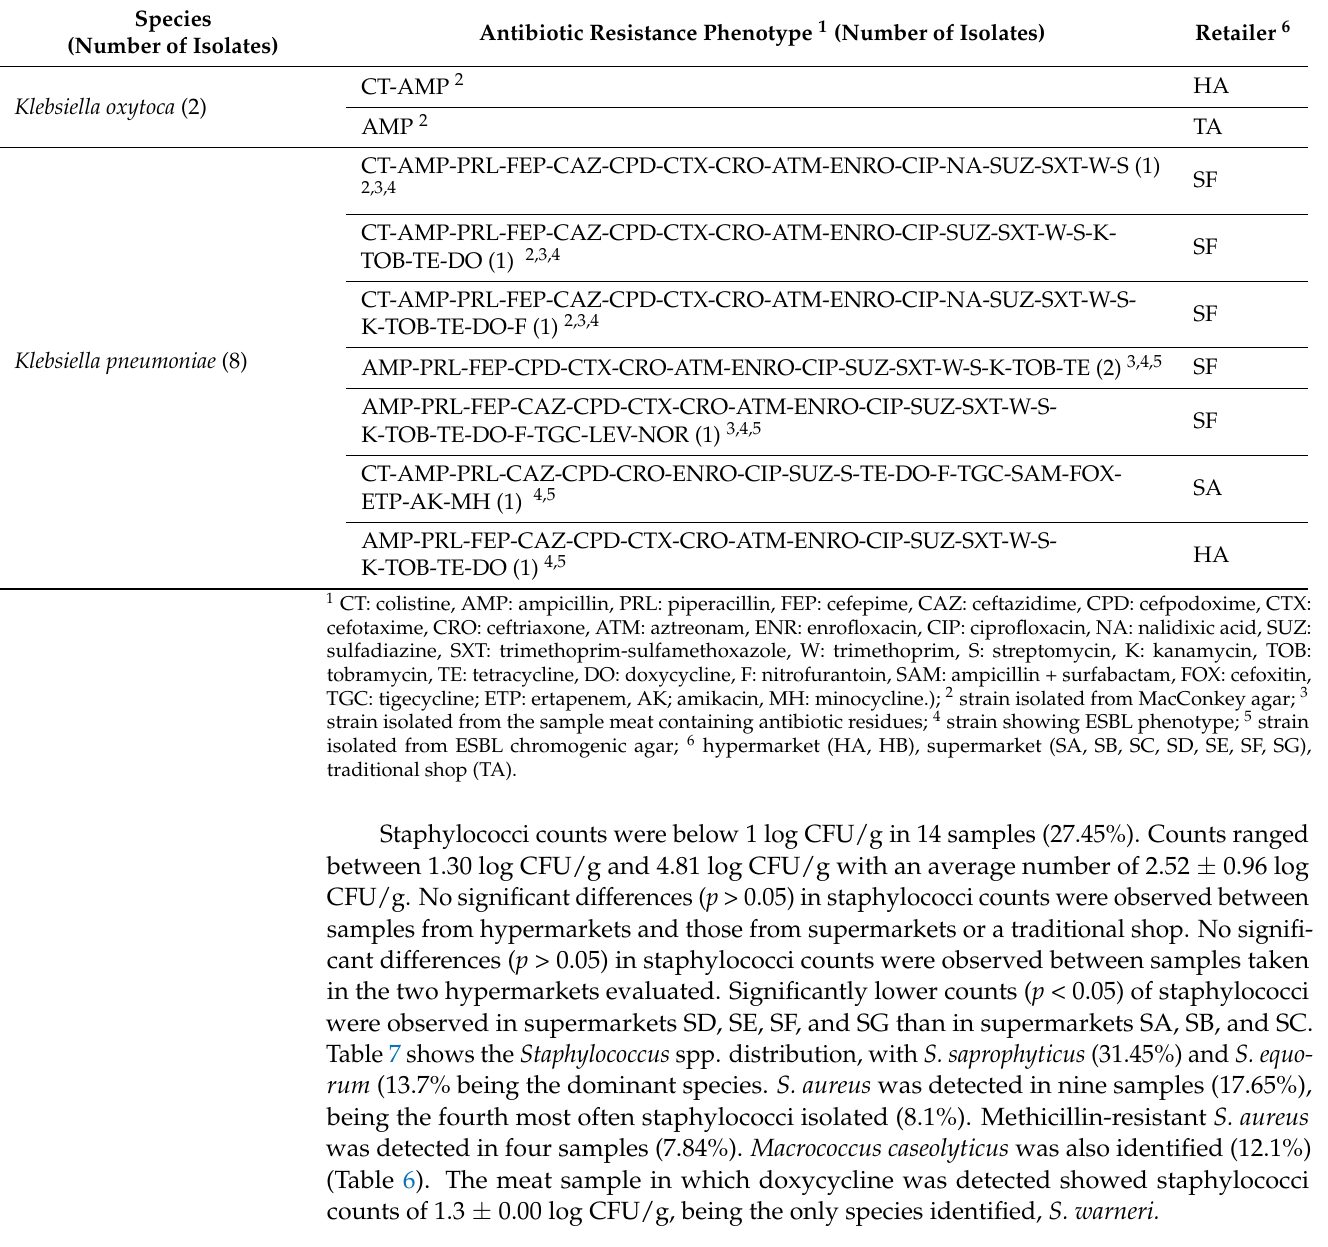
Table 6. Antimicrobial resistance phenotype of Klebsiella spp. isolated from turkey samples.